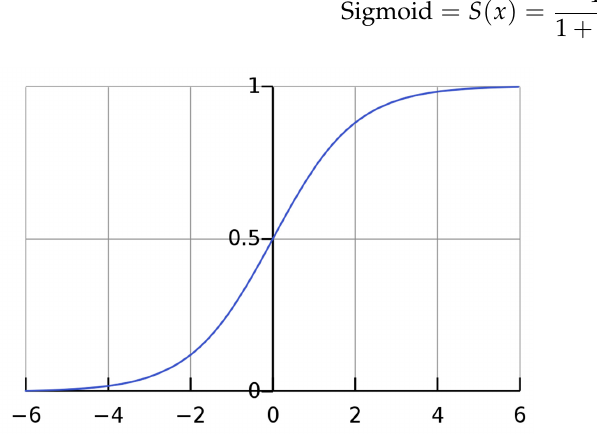
Figure 8. Sigmoid curve.